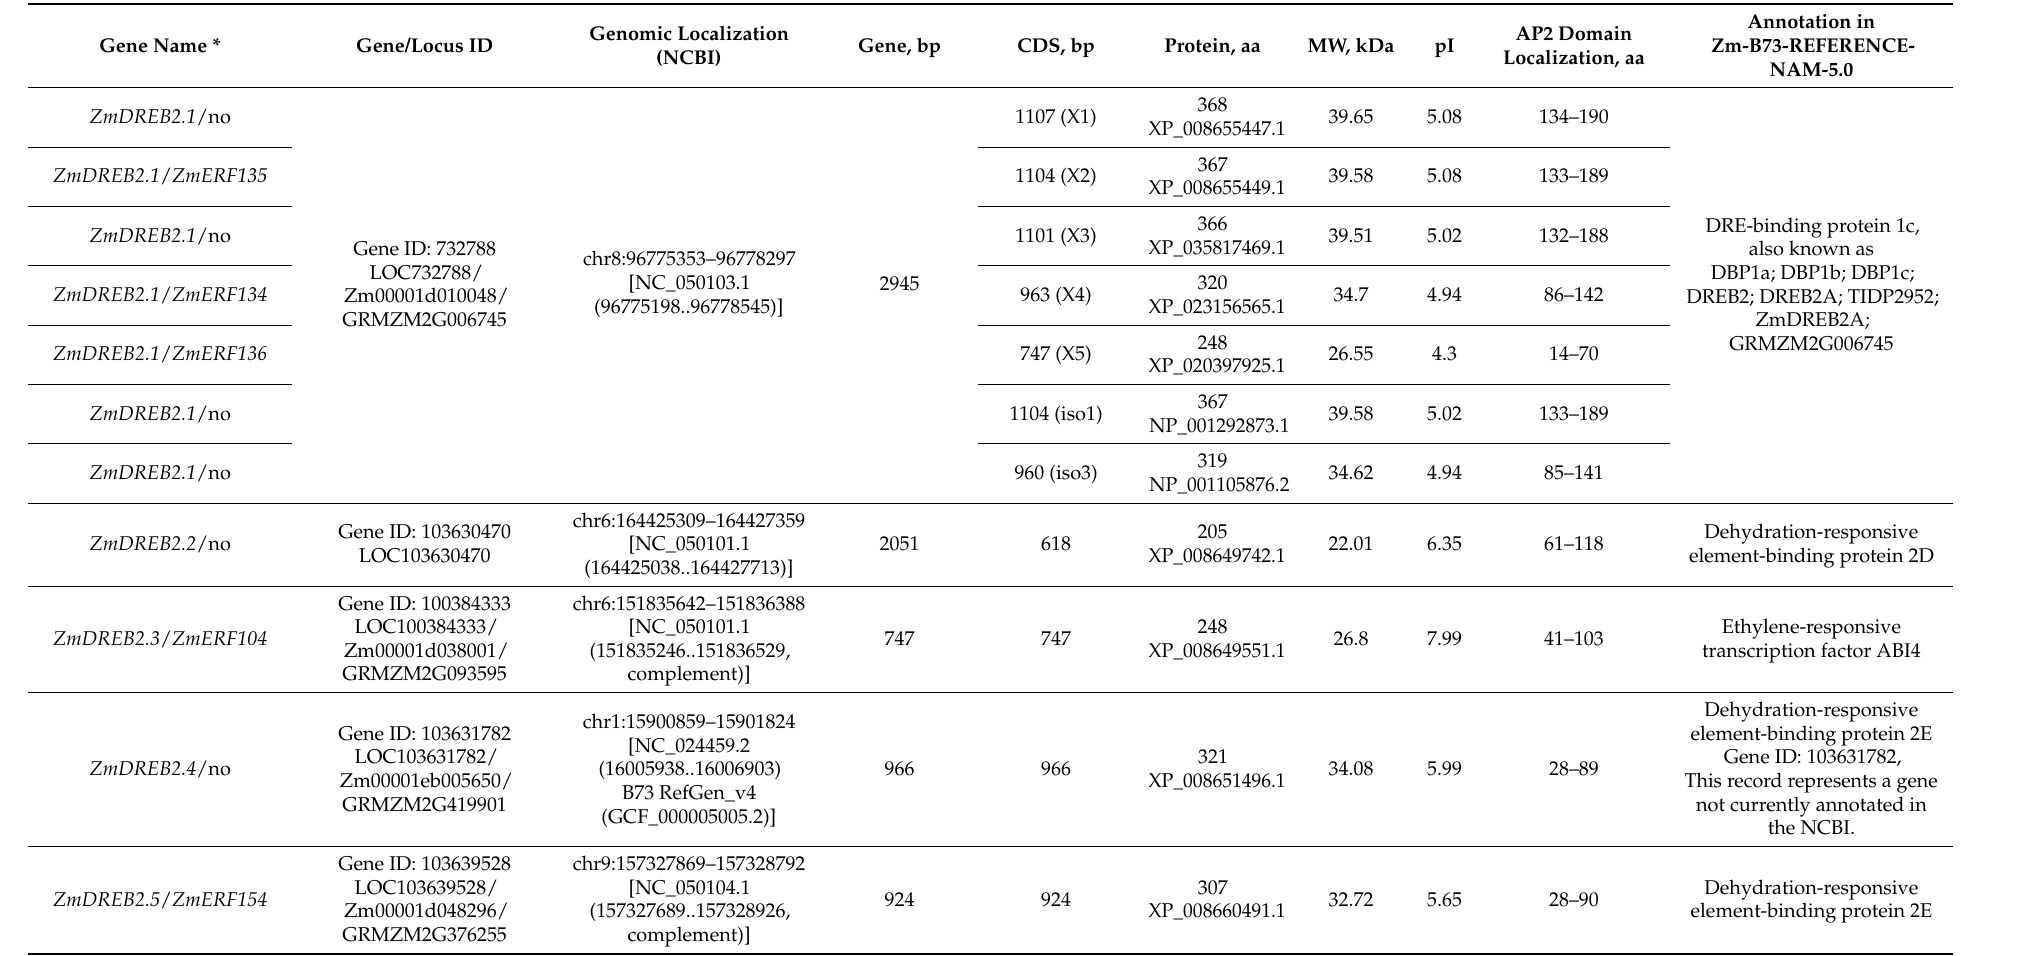
Table 1. Characteristics of the A2-type DREB genes in the Z. mays B73